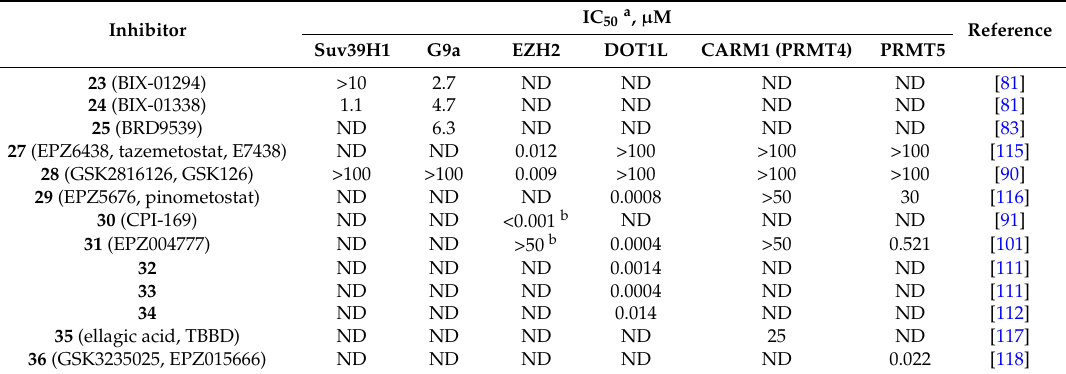
Table 3. HMT inhibitors and their